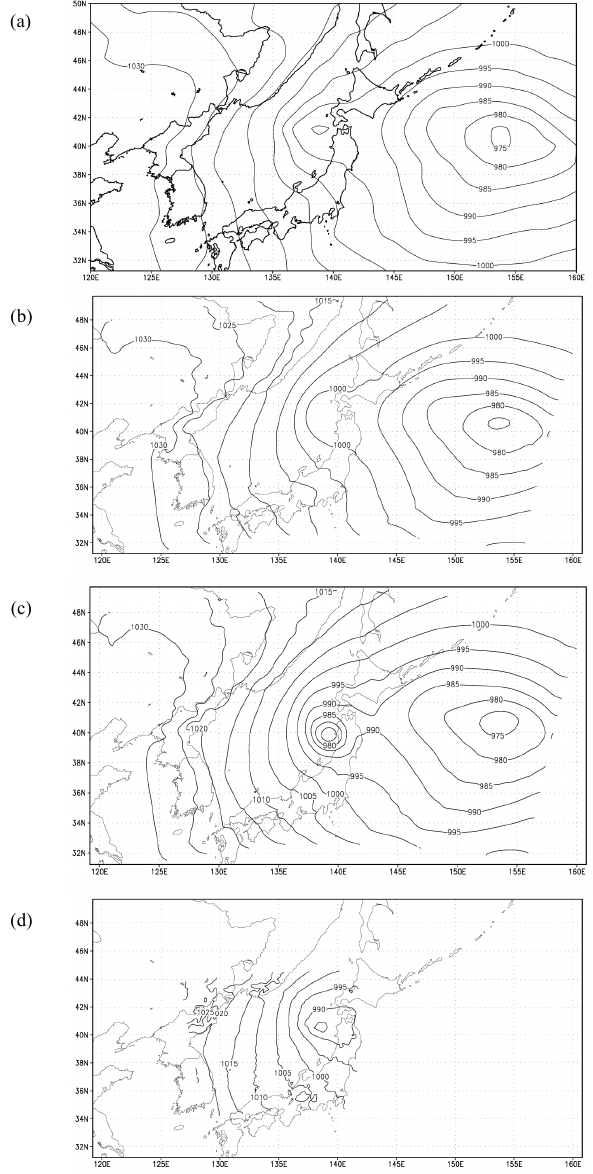
Fig. 4. Sea level pressure of (a) the operational GSM of the JMA GPV, (b) D1 case, (c) D1-TB case, and (d) D2-TB case at 00:00 UTC 20 December 2003.